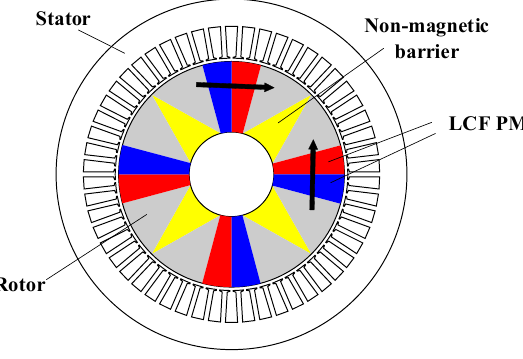
Figure 22. Topology of the original VFM machine [9].